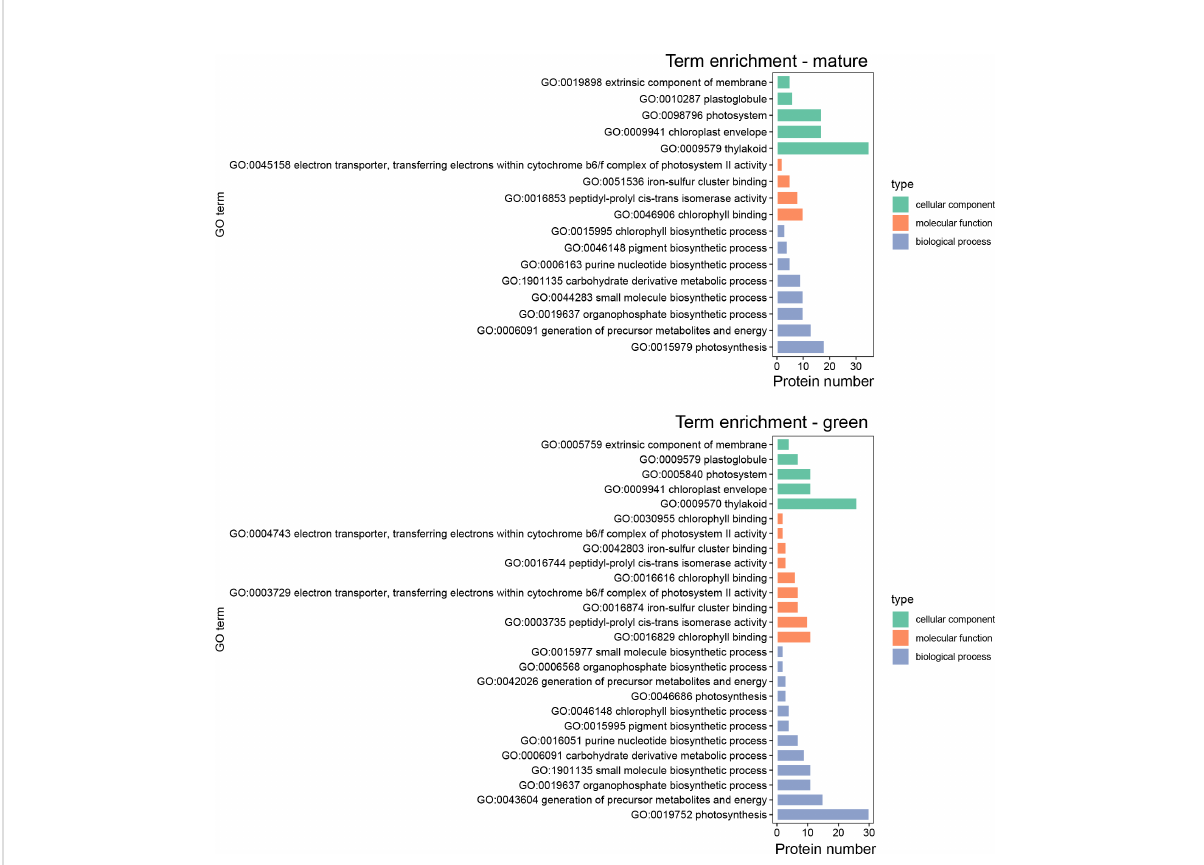
FIGURE 3 Gene Ontology (GO) term enrichment of differentially accumulated proteins (DAPs) in the chloroplasts of Vitis vinifera cv. Vinhão exocarp at the mature stage (E-L 38) vs. the green stage (E-L